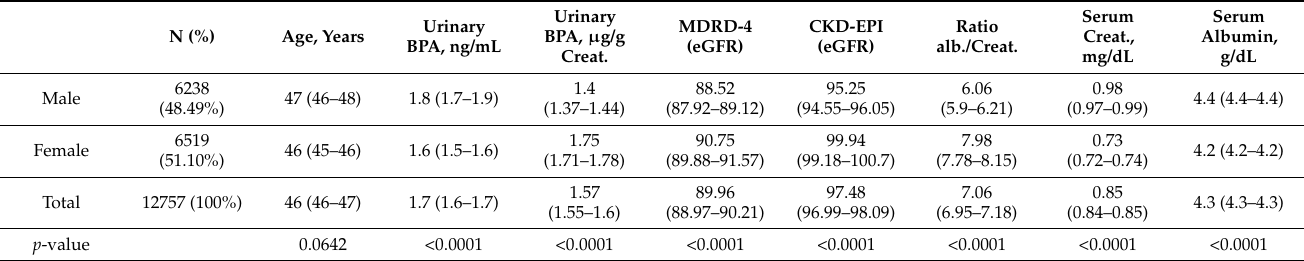
Table 1. Summary of the adult population studied in NHANES 03-16. The data were analyzed using the D’Agostino & Pearson and Kolmogorov–Smirnov normality tests. Data were represented using the median (95% CI). For statistical analysis, the Mann–Whitney test was performed.